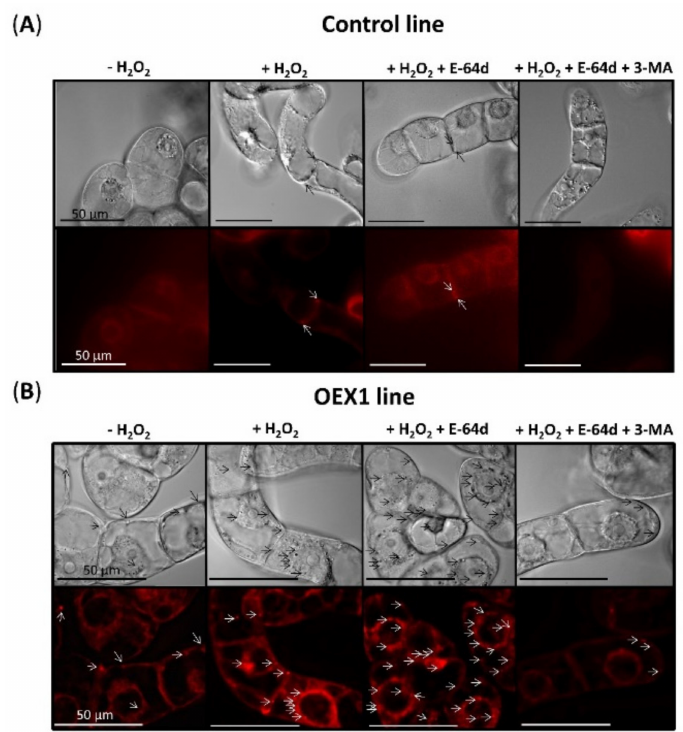
Figure 9. Visualization of H 2 O 2 -induced autolysosomes formation in control ( A ) and overexpressing Pstrxo1 (OEX1) ( B ) tobacco BY-2 cells. Differential interference contrast (DIC) images and fluorescence images of Lysotracker Deep-Red-stained structures are shown as representative of three independent experiments. Five-day-old TBY-2 cells were treated with 35 mM H 2 O 2 alone or in combination with E-64d or E-64d and 3-MA and observed after 14 h under a fluorescence microscope equipped with a Nomarski optic. Arrow heads indicate some punctate signals of autolysosomes (red). Scale bars: 50 µ